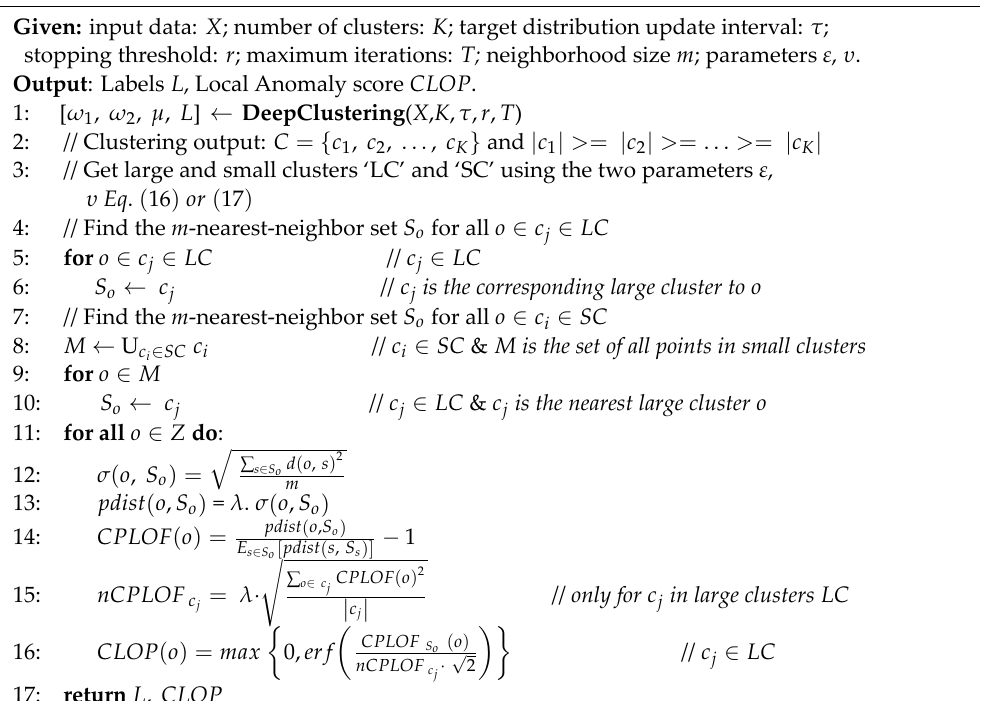
Algorithm 2: Deep Clustering‑based Local Outlier Probabilities